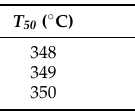
Table 2. Thermal data derived from the TGA curves and DTA curves of neat PLLA, PSG and PGN